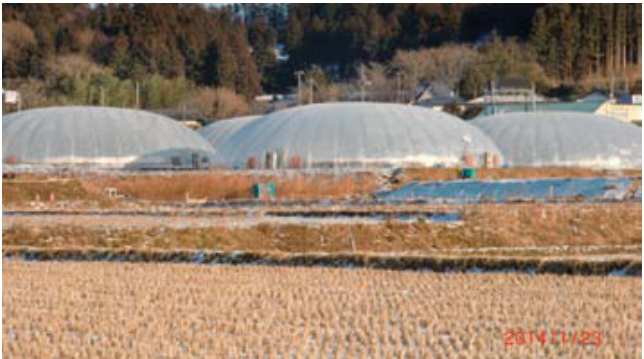
2013.Fig. 4 - A solar-type plant factory constructed in the area affected by the Great East Japan Earthquake that occurred on 11 March 2011.